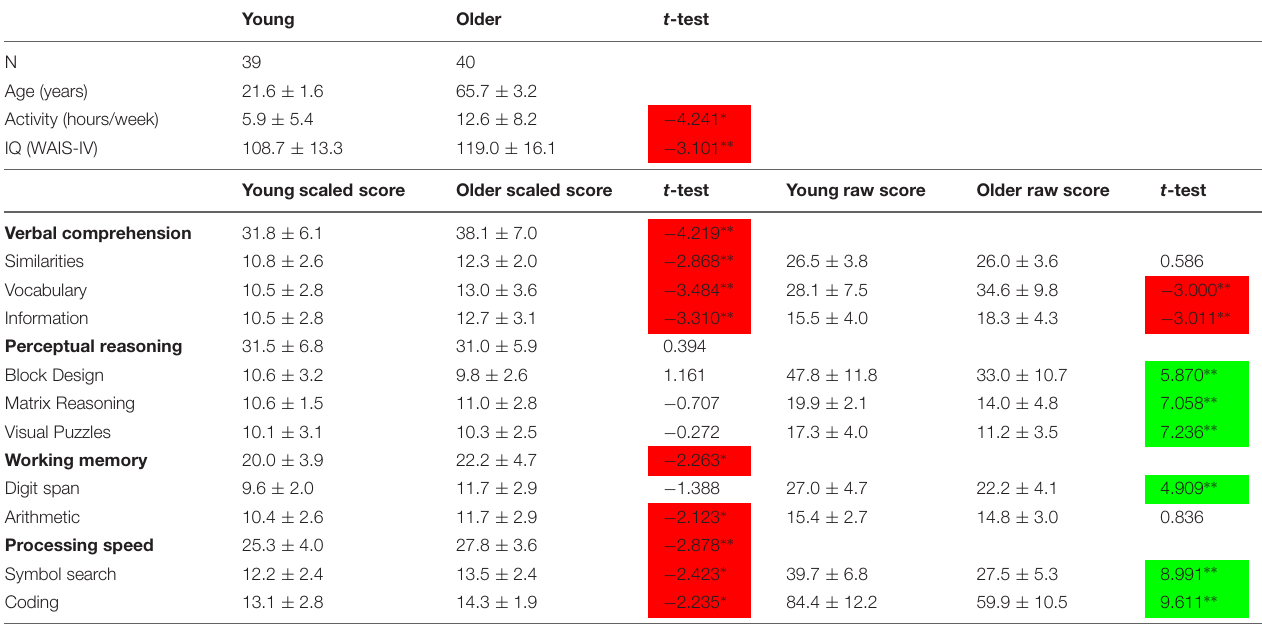
Red boxes indicate better results in older adults, green boxes index better performance in young adults. ∗ p < 0.05; ∗∗ p < 0.01.